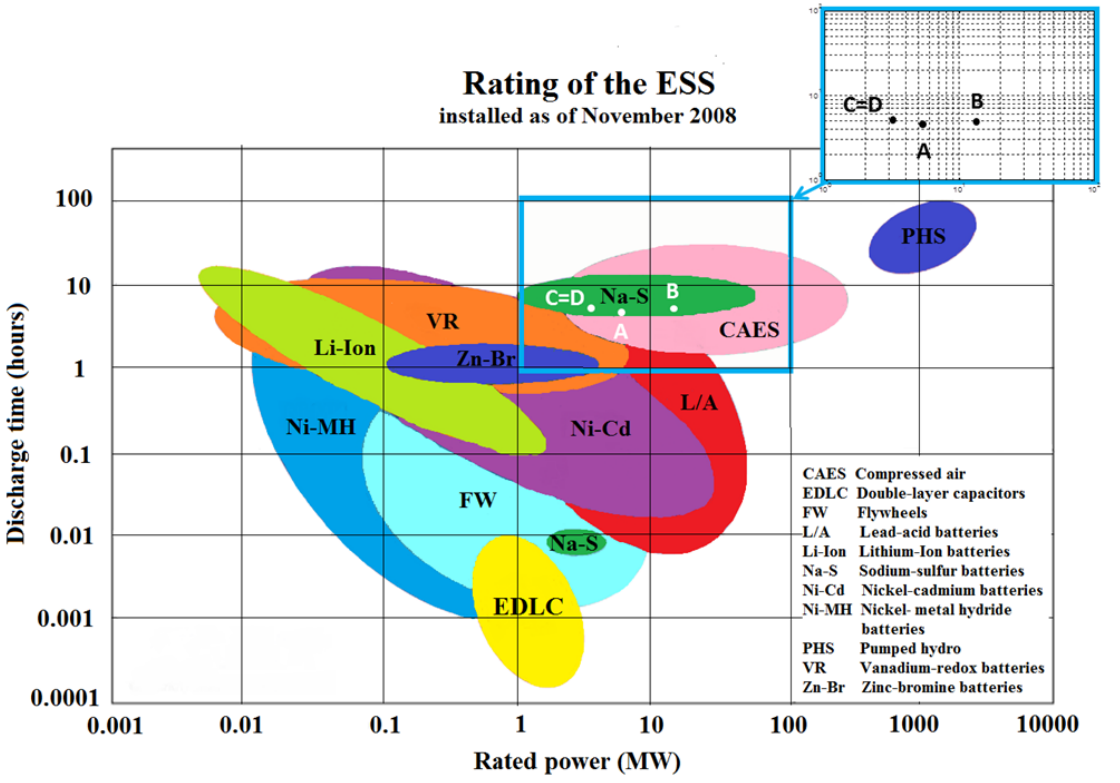
Figure 11. ESS technology applicability based on the state of the applied art (reproduced from